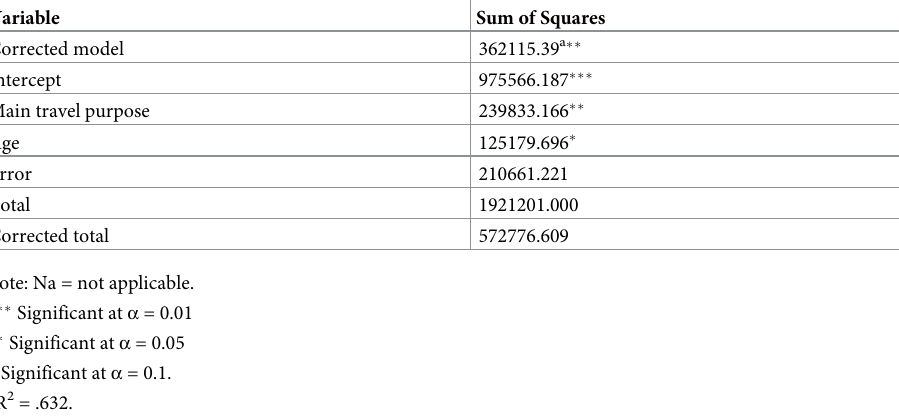
Table 6. ANOVA of UGA.